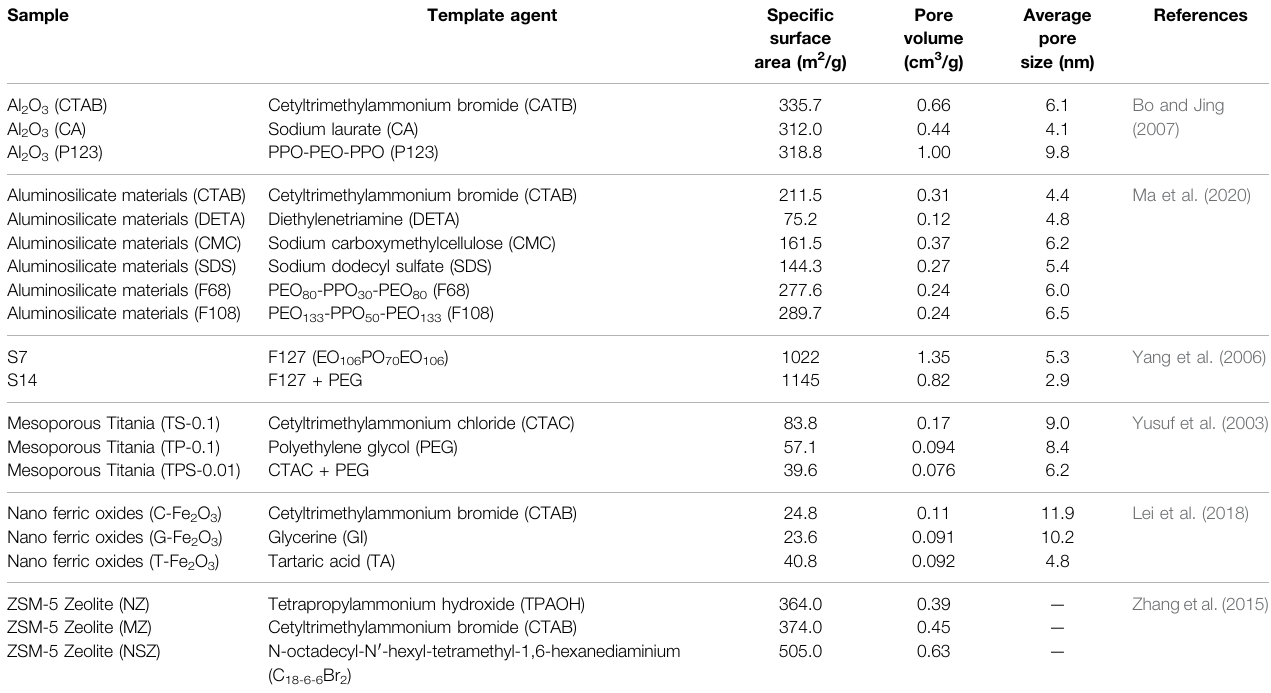
TABLE 1 | Structural parameters of the samples synthesized with different templates.